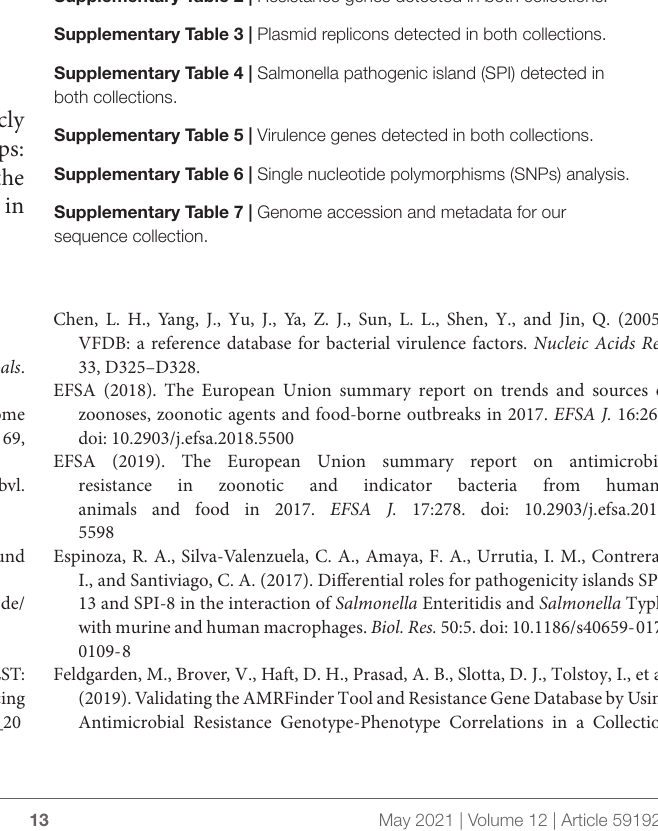
Supplementary Table 1 | Genome accession and metadata for public sequence collection. Supplementary Table 2 | Resistance genes detected in both collections. Supplementary Table 3 | Plasmid replicons detected in both collections.